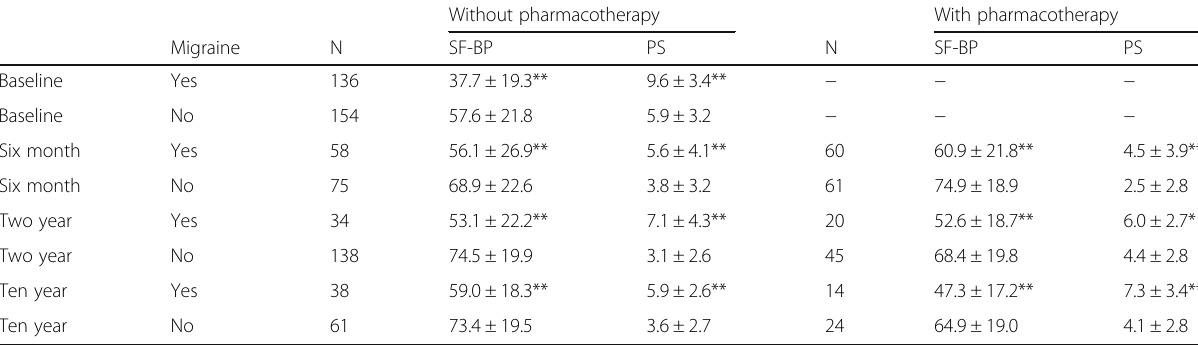
Table 2 The differences of the pain indices at four time points between patients with and without migraine Without pharmacotherapy With pharmacotherapy